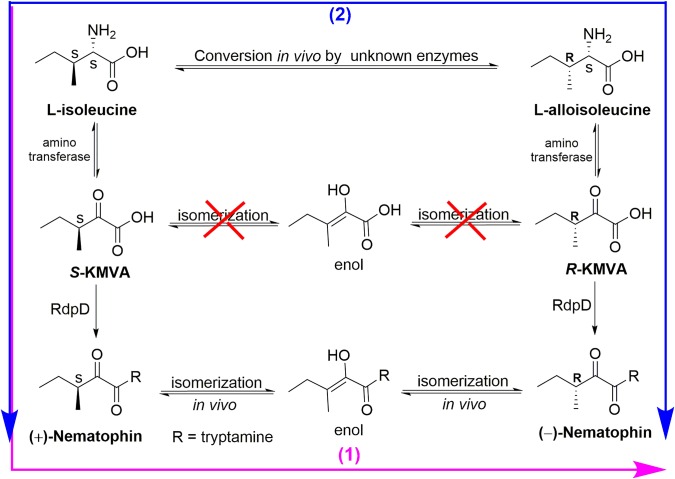
Two deductive pathways involved in the biosynthetic origin of (±)-nematophin (NEP-1).